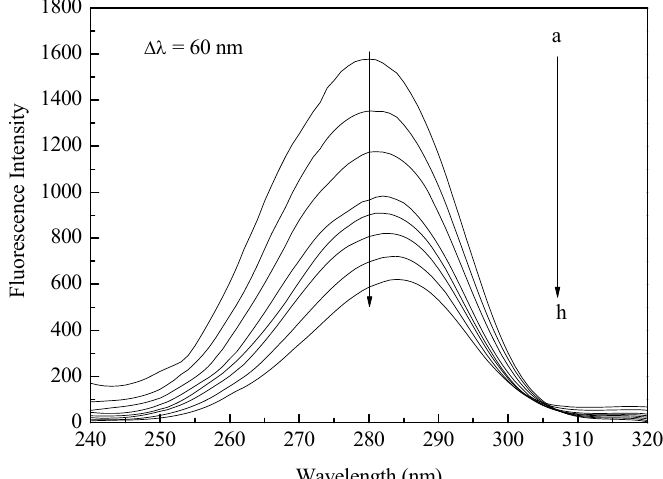
(a): 3.8 × 10 − 6 mol.L − 1 HSA, (b → h): 3.8 × 10 − 6 mol.L − 1 HSA with the addition of 2.0, 4.0, 6.0, 8.0, 10.0, 12.0, 14.0 × 10 − 5 mol.L − 1